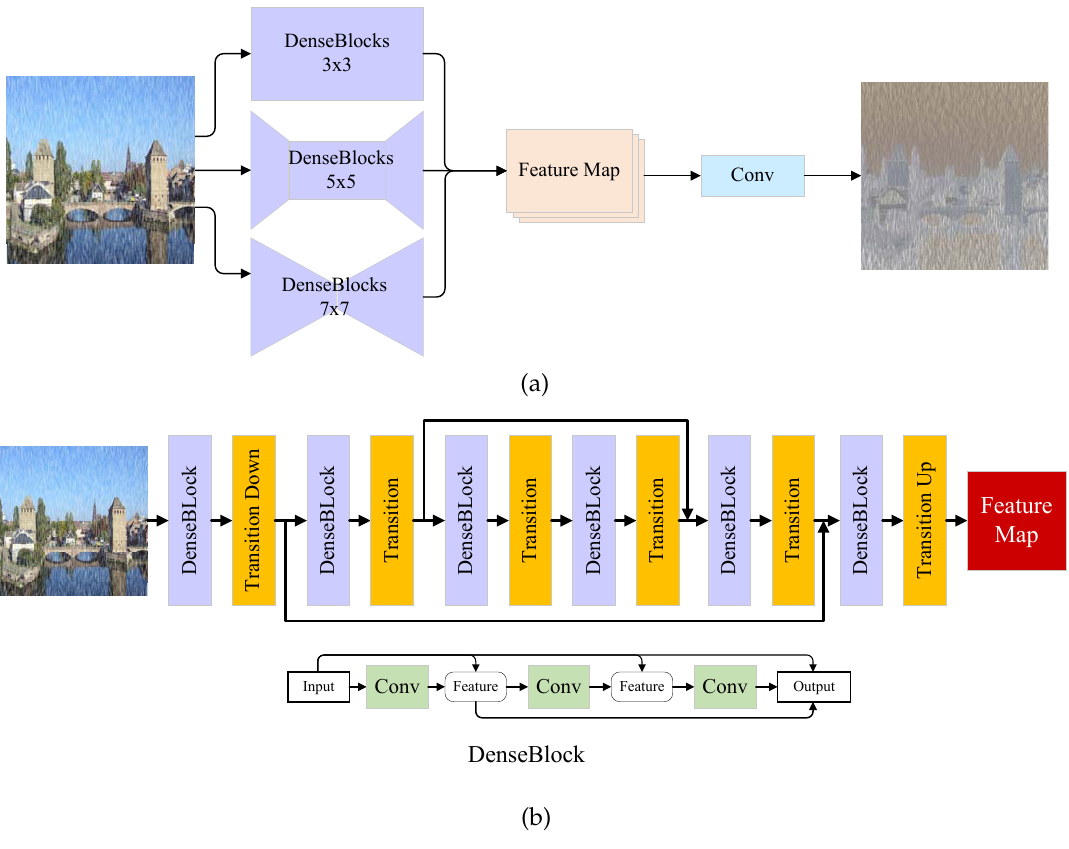
Figure 3. The architecture of Rain Estimation Network. ( a ) The overview of REN. It consists of three-stream DenseNet [23] with different kernel size, i.e., 3 × 3, 5 × 5 and 7 × 7. ( b ) The architecture of 5 × 5 DenseNet stream. The transition down means a stride-2 convolution layer with ReLU and IN. The transition up means a stride-2 deconvolution layer with ReLU and IN. The transition up means a stride-1 convolution layer with ReLU and IN. Each dense block has four convolution layers as